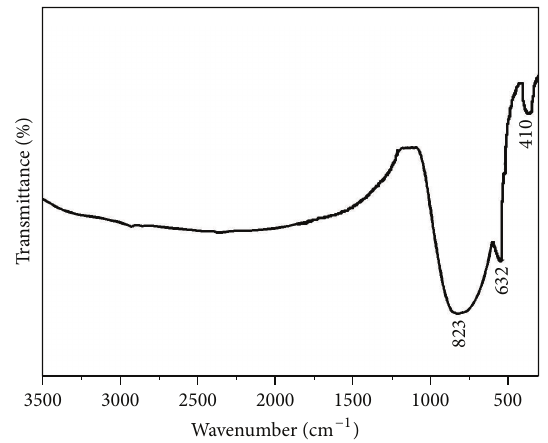
Figure 4: FT-IR spectrum of as-prepared nano-BaWO 4 prepared by combustion